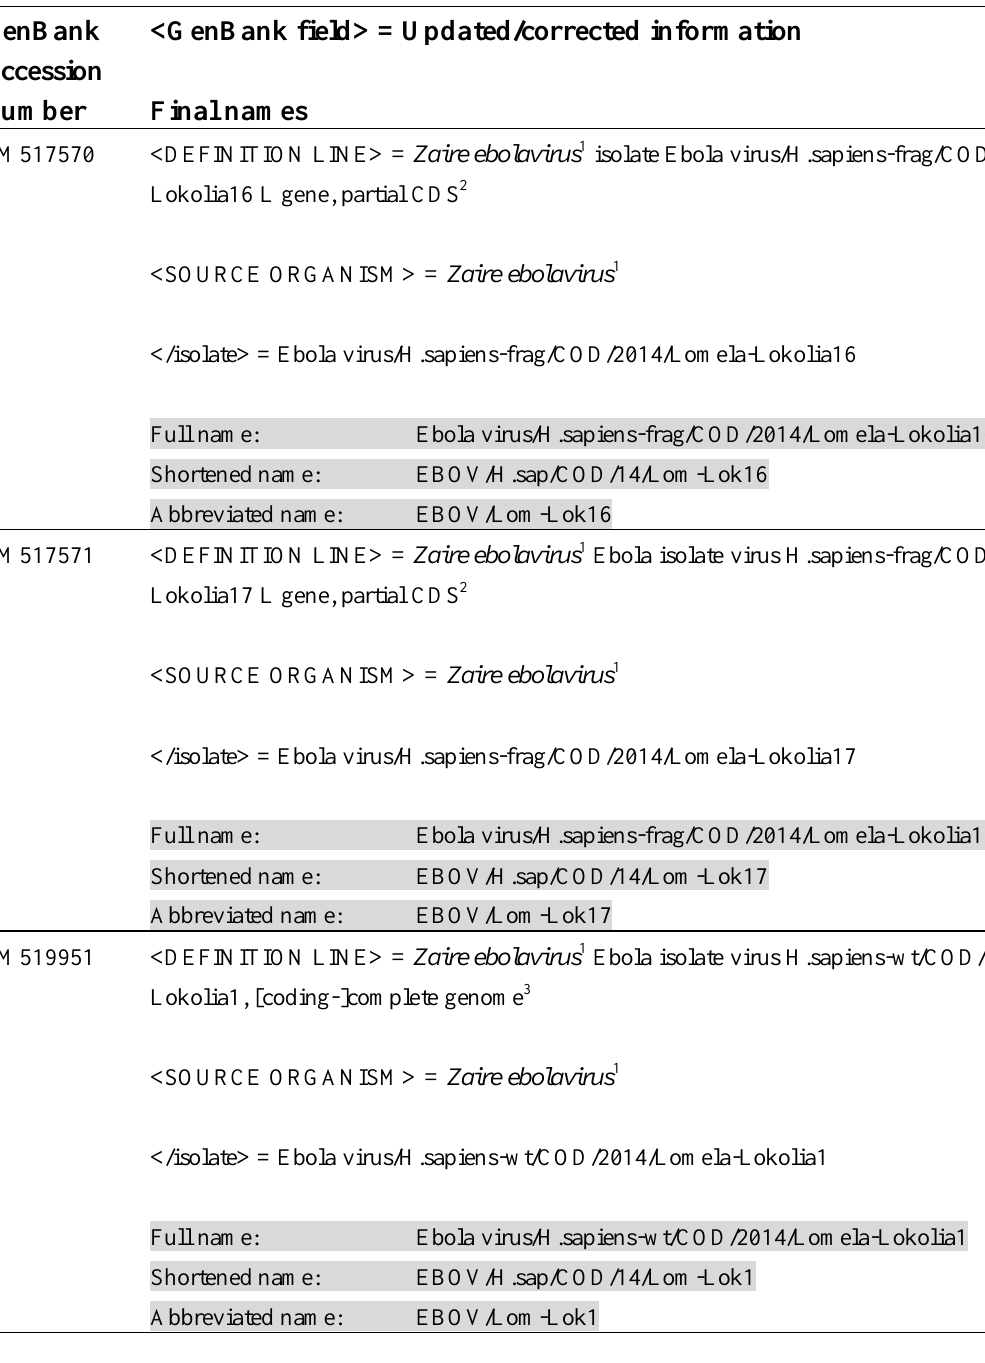
Table 4. EBOV isolates from the Democratic Republic of the Congo Boende EVD out- break, 2014: Updated and/or corrected GenBank information and final